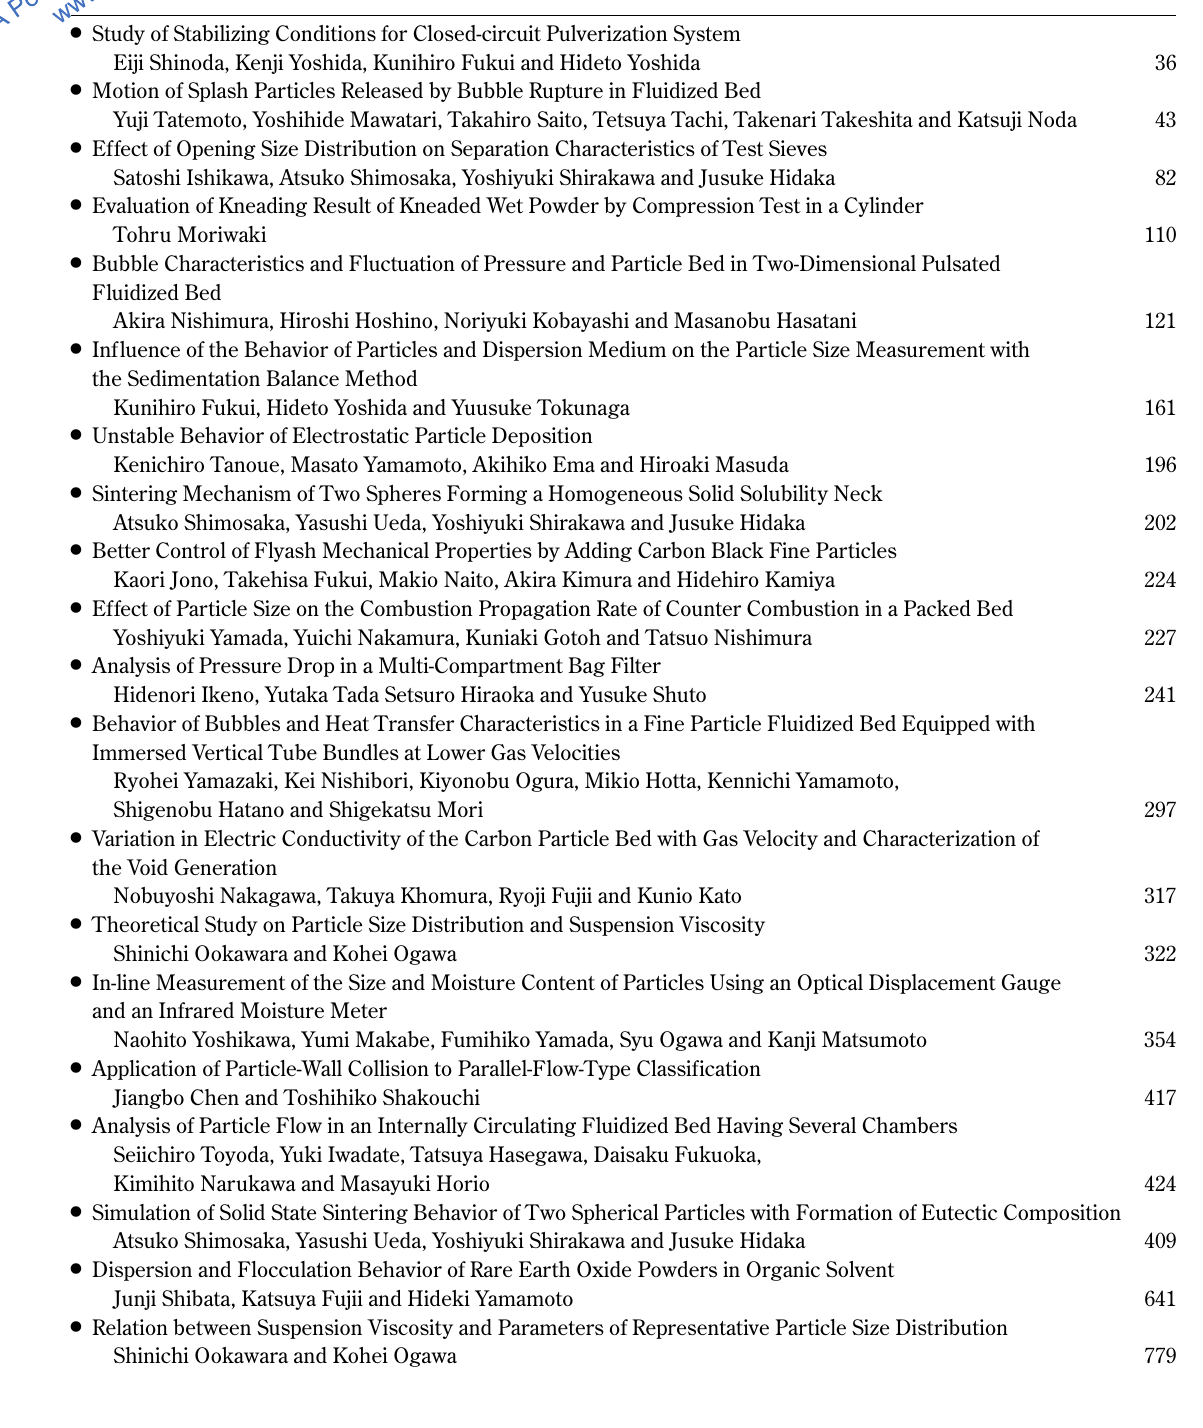
and an Infrared Moisture